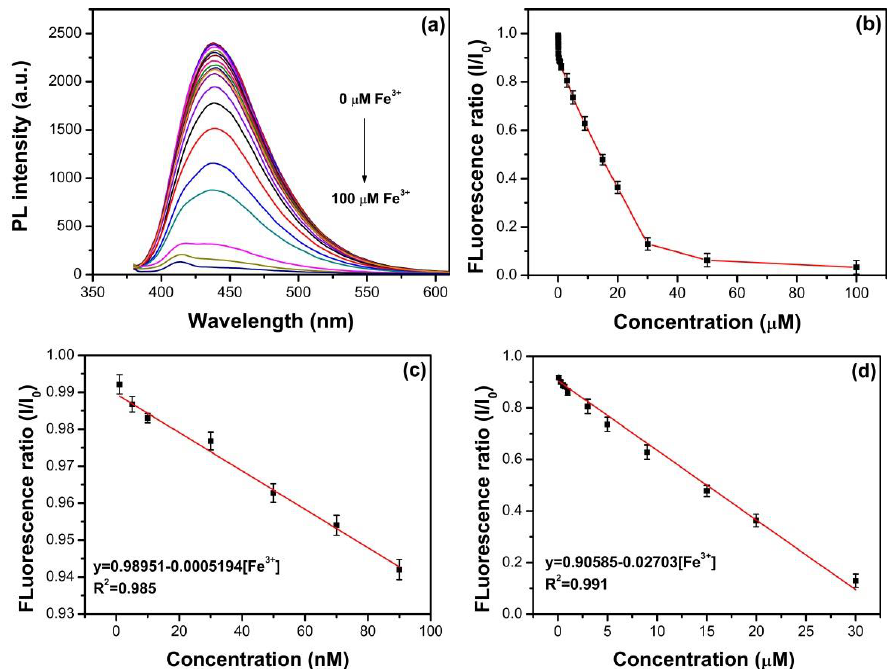
Figure 11. ( a ) Fluorescence response of N, S-GQDs by adding various concentrations of Fe 3 + ranging from 0 to 100 µ M, ( b ) the relationship between fluorescence ratio and Fe 3 + concentration, ( c , d ) the dynamic response range for Fe 3 + detection in the ranges 1–90 nM and 0.1–30 µ M, respectively.